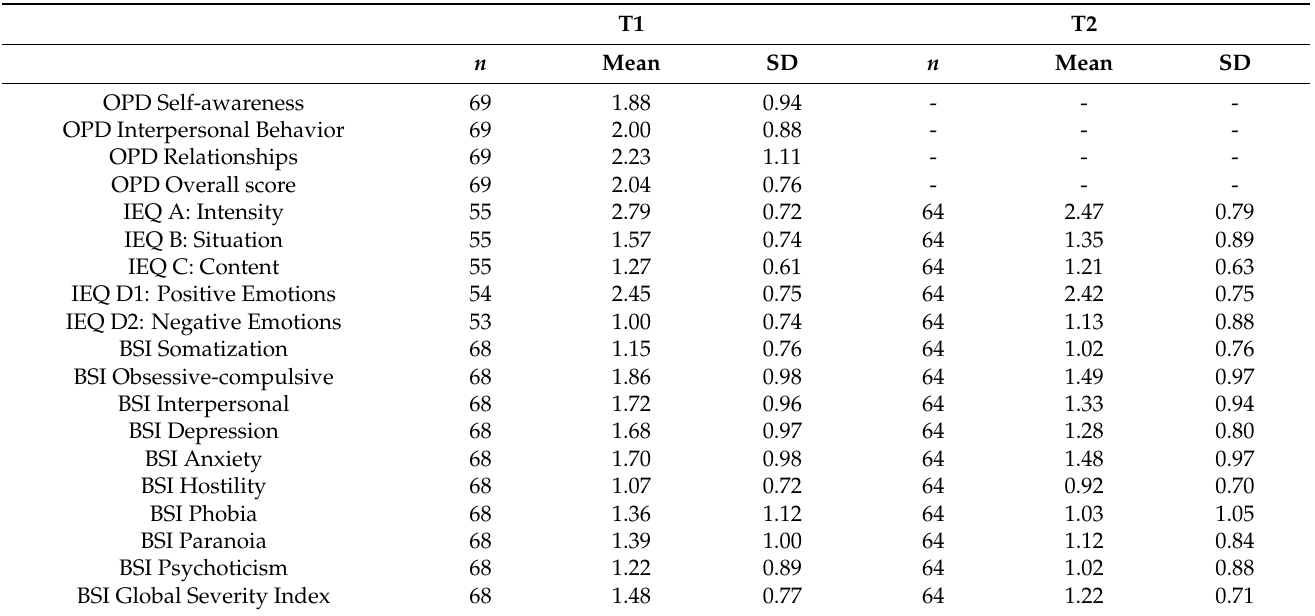
Table 2. Descriptive data on OPD Structure Questionnaire Short (OPD-SQS), Intersession Experience Questionnaire (IEQ), and Brief Symptom Inventory (BSI).